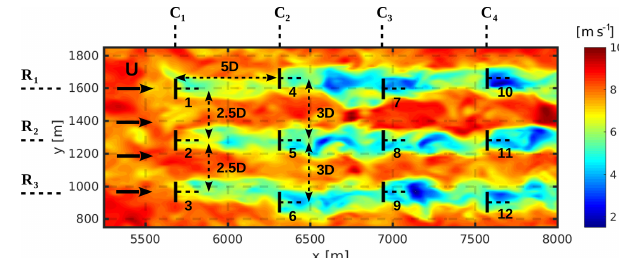
Figure 3. The layout of the waked 3 × 4 wind farm model simulated with PALM. R i and C j stand for the i th row and the j th column of the simulated wind turbines, respectively.